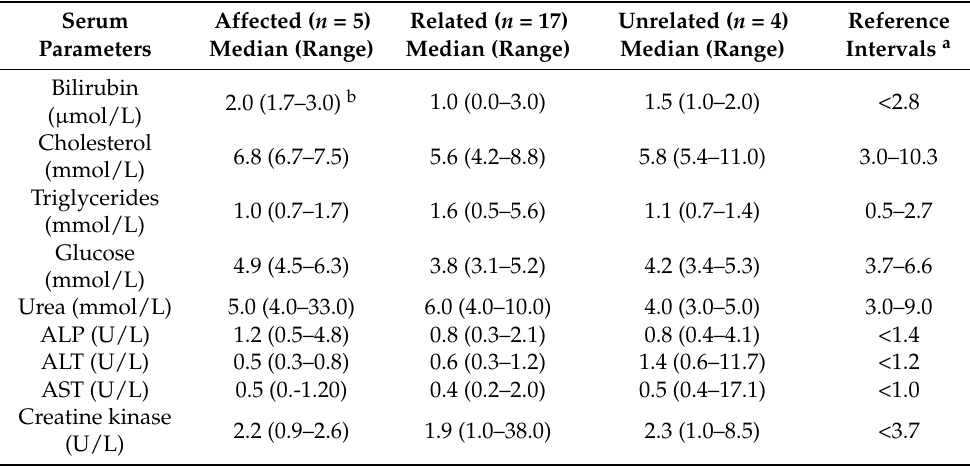
Table 2. Serum chemistry results from affected, related, and unrelated English springer spaniels.